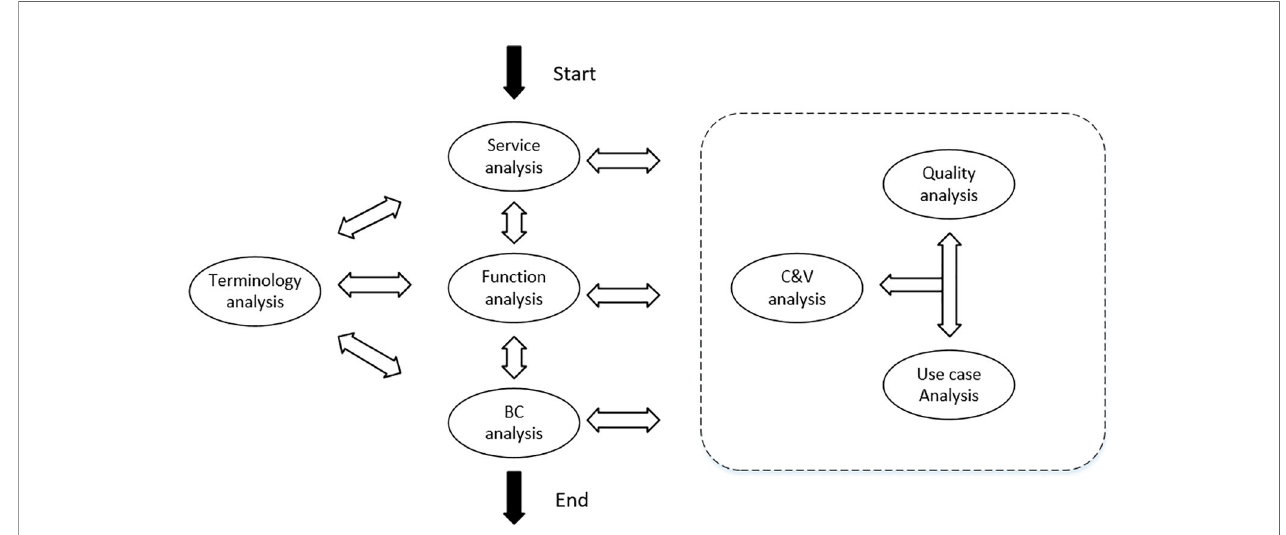
FIGURE 2 | Feature modeling